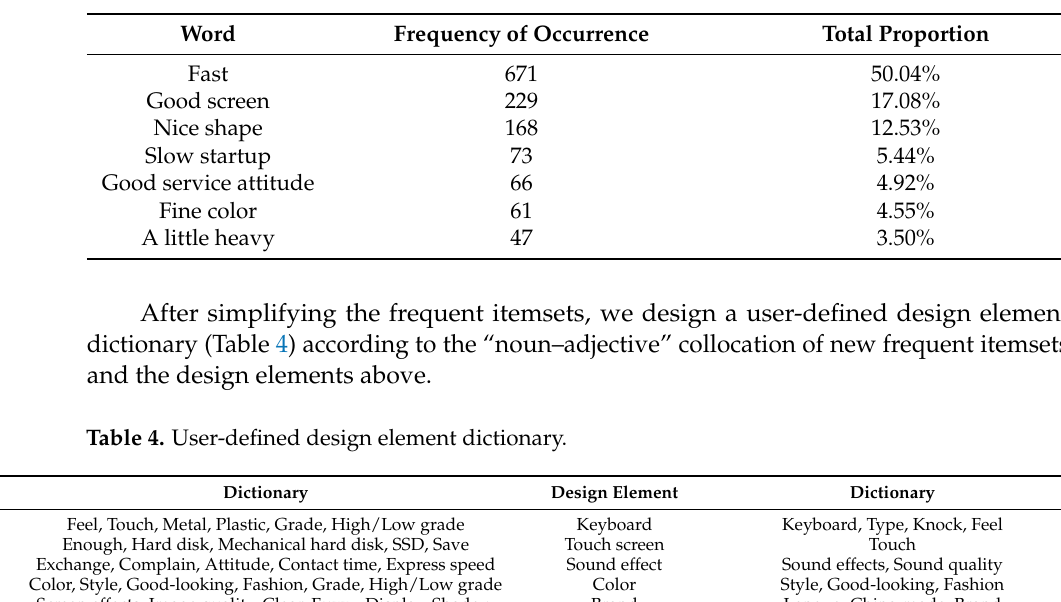
Table 3. High-frequency vocabulary statistics (part).